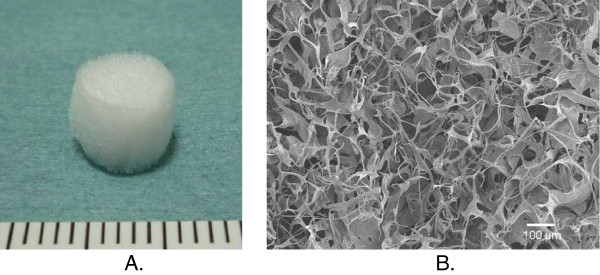
A salmon-derived cross-linked atelocollagen sponge disc containing OP-1 (OP-1SCS disc) as a novel cell-free device for cartilage repair (A) and the ultrastructure of the atelocollagen sponge (B).